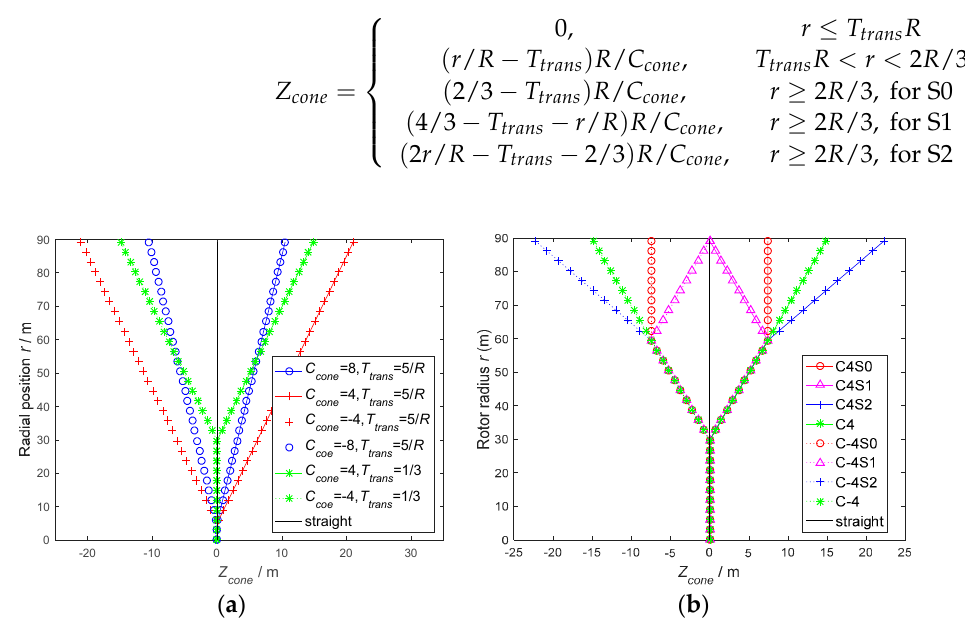
Figure 2. Conning configurations: ( a ) T trans = 5/R with C cone = ±4, ±8 and T trans = 1/3 with C cone = ±4; ( b ) special configurations abbreviated as C4S0, C4S1, C4S2, C4, C-4S0, C-4S1, C-4 S2 and C-4.